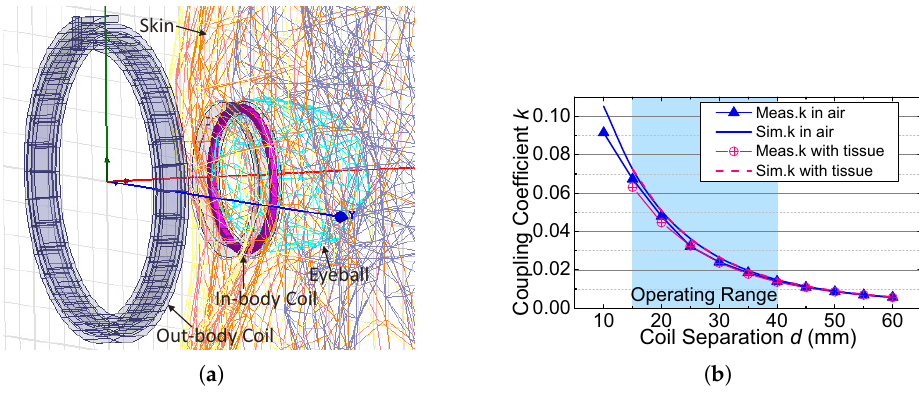
Figure 19. ( a ) Inductive link simulation with the human head model in ANSYS HFSS; and ( b ) measured and simulated k in air and in